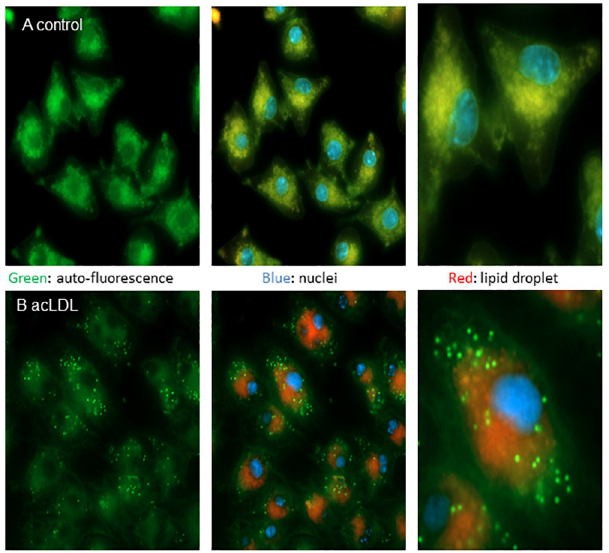
Fig 12. AcLDL uptake by J774A.1 macrophages induces auto-fluorescent puncta distinct from the lipid droplet. Vehicle (A, top panels), or AcLDL (B, bottom panels, 40 μ g/ml), was added to cultures for 24 h and cells were imaged for auto-fluorescence (green) nuclei (blue) and lipid droplets (red) with right panels showing selected cells in more detail from the center panels.